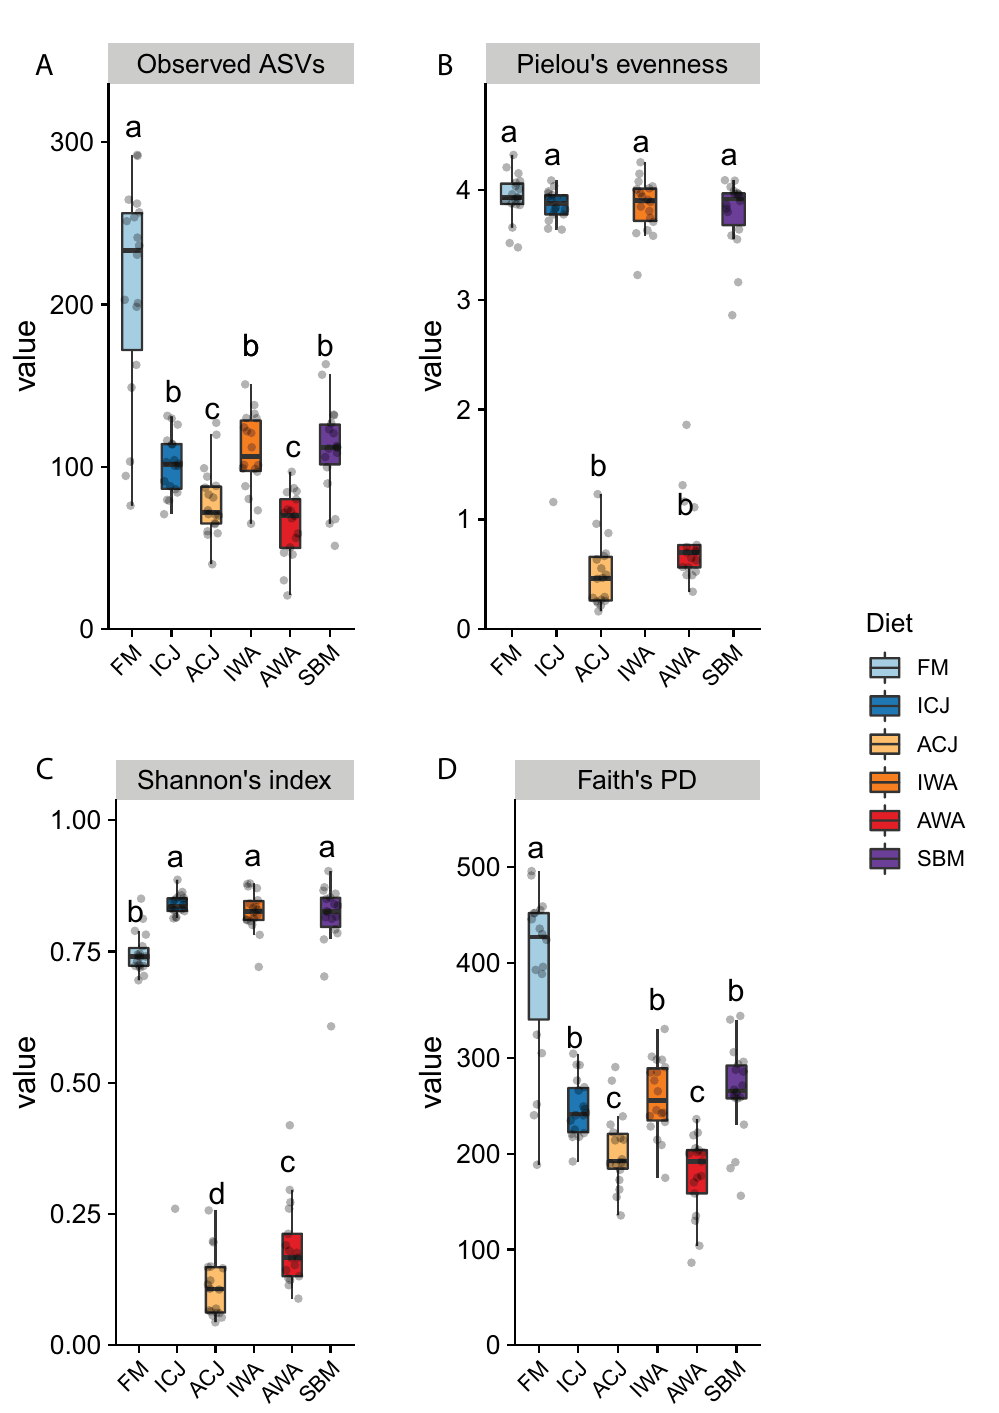
Fig. 5 Boxplots of alpha-diversity of gut microbiota of fish fed the experimental diets. The four alpha-diversity indices used are; ( a ) observed amplicon sequence variants (ASVs), ( b ) Pielou’s evenness ( c ) Shannon’s index and ( d ) Faith’s phylogenetic diversity (PD). The samples are grouped by diets; FM—fishmeal-based; SBM—soybean meal-based; 4 experimental diets containing 300 g/kg SBM and 100 g/kg of ICJ—inactivated Cyberlindnera jadinii ; ACJ—autolyzed C. jadinii ; IWA—inactivated Wickerhamomyces anomalus ; AWA—autolyzed W. anomalus diets. Indices with different lower-case letters are significantly different ( p < 0.05) among the